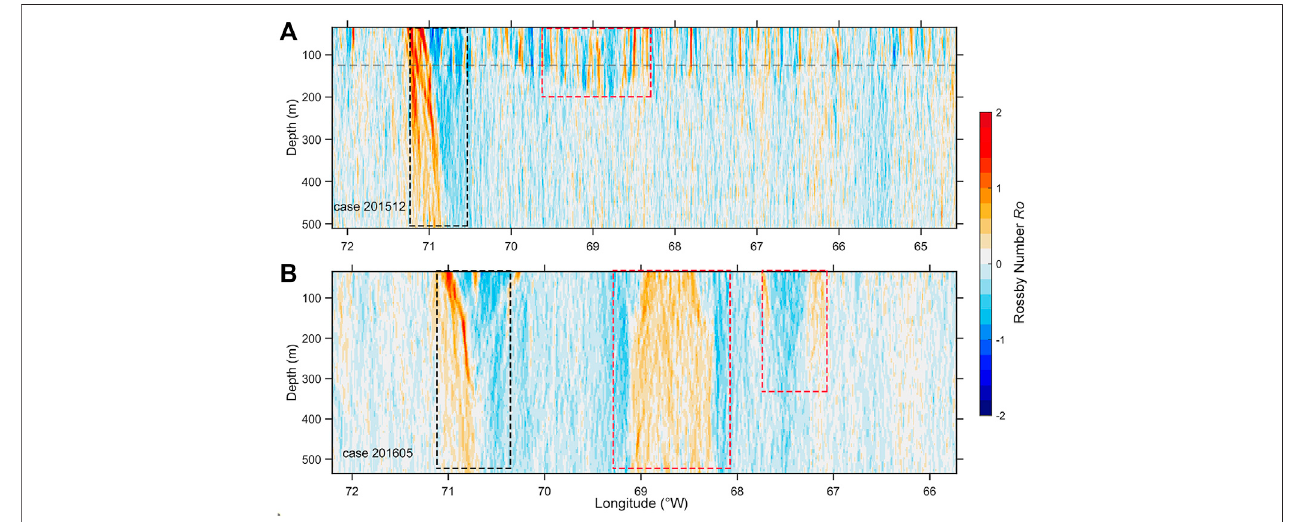
FIGURE 2 | Longitude – depth variations of Ro in case 201512 (A) and case 201605 (B) . The gray dashed line marks the mean mixed layer depth 125 m in winter. The black dashed boxes mark the Gulf Stream position, while the red dashed boxes represent the position of mesoscale eddies that generate/in fl uence submesoscale motions.